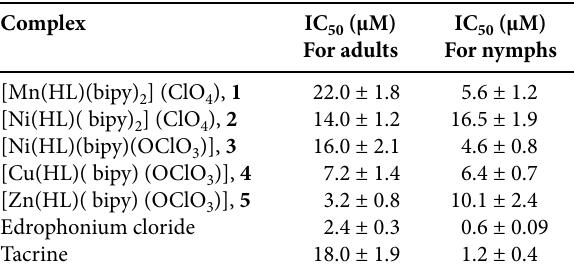
Table 7. IC 50 values of acetylcholinesterase of R. simulans in the presence of the complexes ( 1-5 ). Complex IC 50 (µM) IC 50 (µM) For adults For